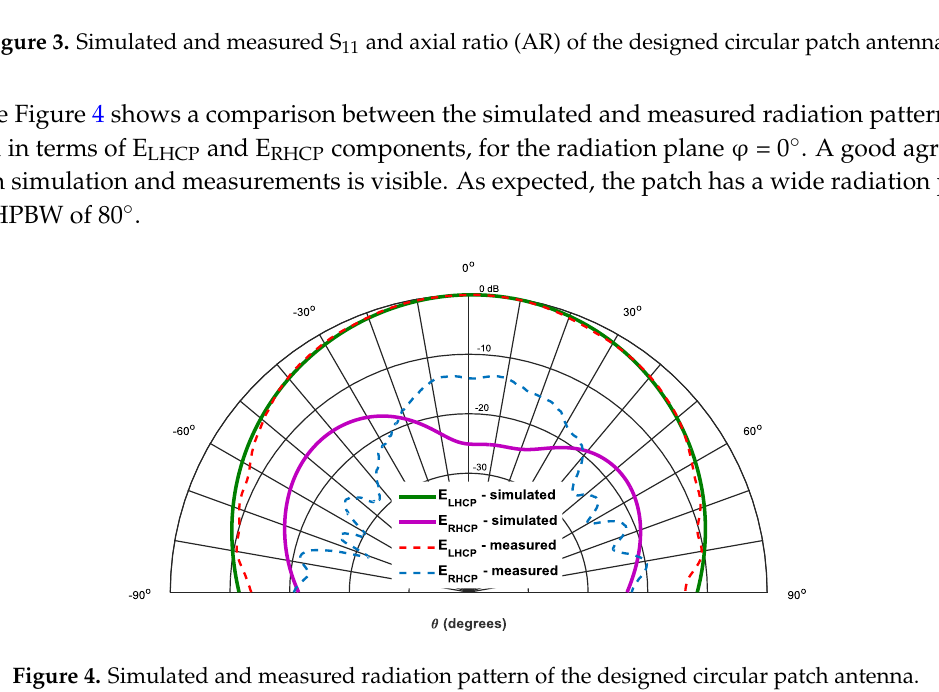
Figure 4. Simulated and measured radiation pattern of the designed circular patch antenna.